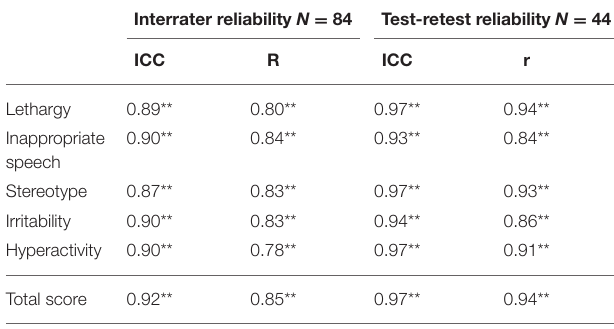
TABLE 2 | Spearman’s rank correlation coefficients for